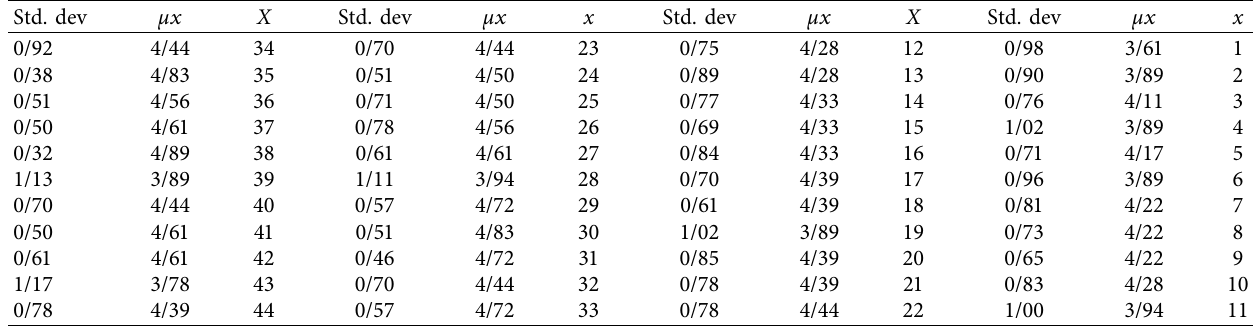
Table 3: Results of expert surveys on system output in each of the simulated conditions.